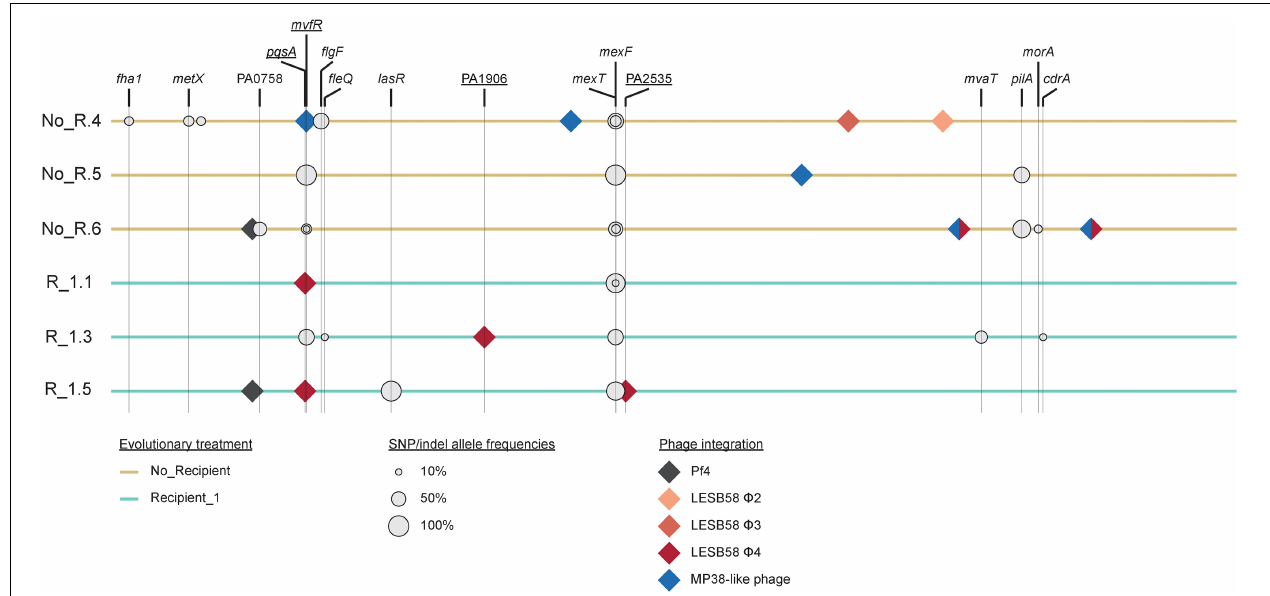
FIGURE 3 | Genetic changes in populations evolved without recipient (No_R.4, No_R.5, and No_R.6) or in the presence of Recipient 1 (R_1.1, R_1.3, and R_1.7). Relative size of gray circles reflects SNP or indel frequency within each population. All sequenced evolved populations contained one or more prophage elements that were not present in the ancestral strain. Genes that were disrupted by phage integration in at least one replicate population are underlined. Because border regions of LESB58 (cid:56) 4 and MP38-like phage are identical, it is not possible to determine which phage integrated where in population No_R.6 (two-colored diamonds). Supplementary Tables 1 , 2 provide further details on specific SNPs and indels as well as on copy number